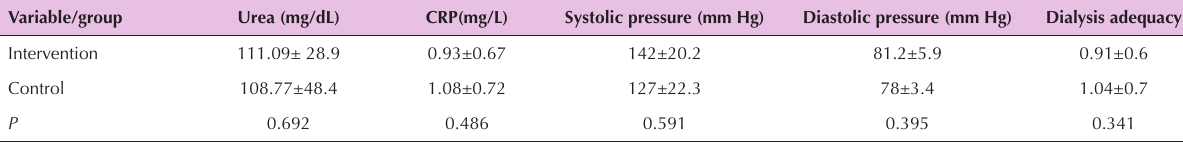
Table 1. The comparison of data of both groups at the beginning of the study Variable/group